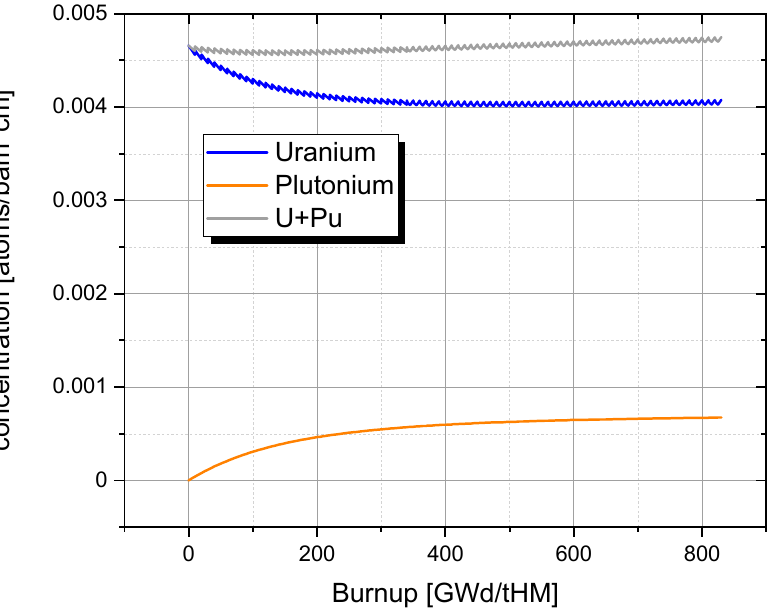
Figure 11. Change in the elementary content of heavy metals over burnup for the simulation based on using 10 GWd/tHM steps and an initiation of the clean-up system after 50 GWd/tHM as shown above.